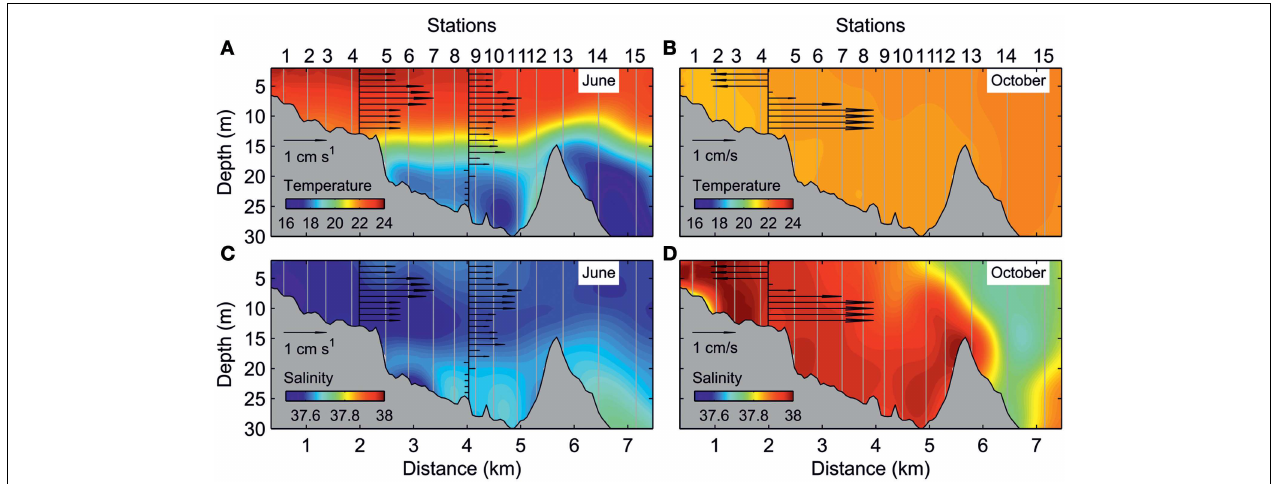
FIGURE 3 | Along-estuary transect of: temperature ( ◦ C) for (A) June and (B) October surveys, and salinity for (C) June and (D) October surveys. The black arrows indicate the daily averaged axial currents (cm s − 1 ) at different depths.